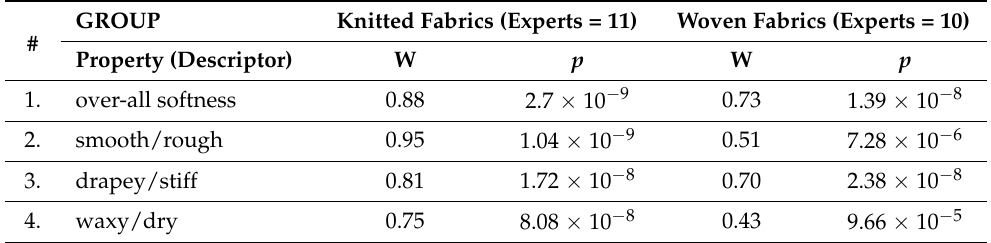
Table 3. Kendall concordance factor for the hand-feel panel ranking according to different describing